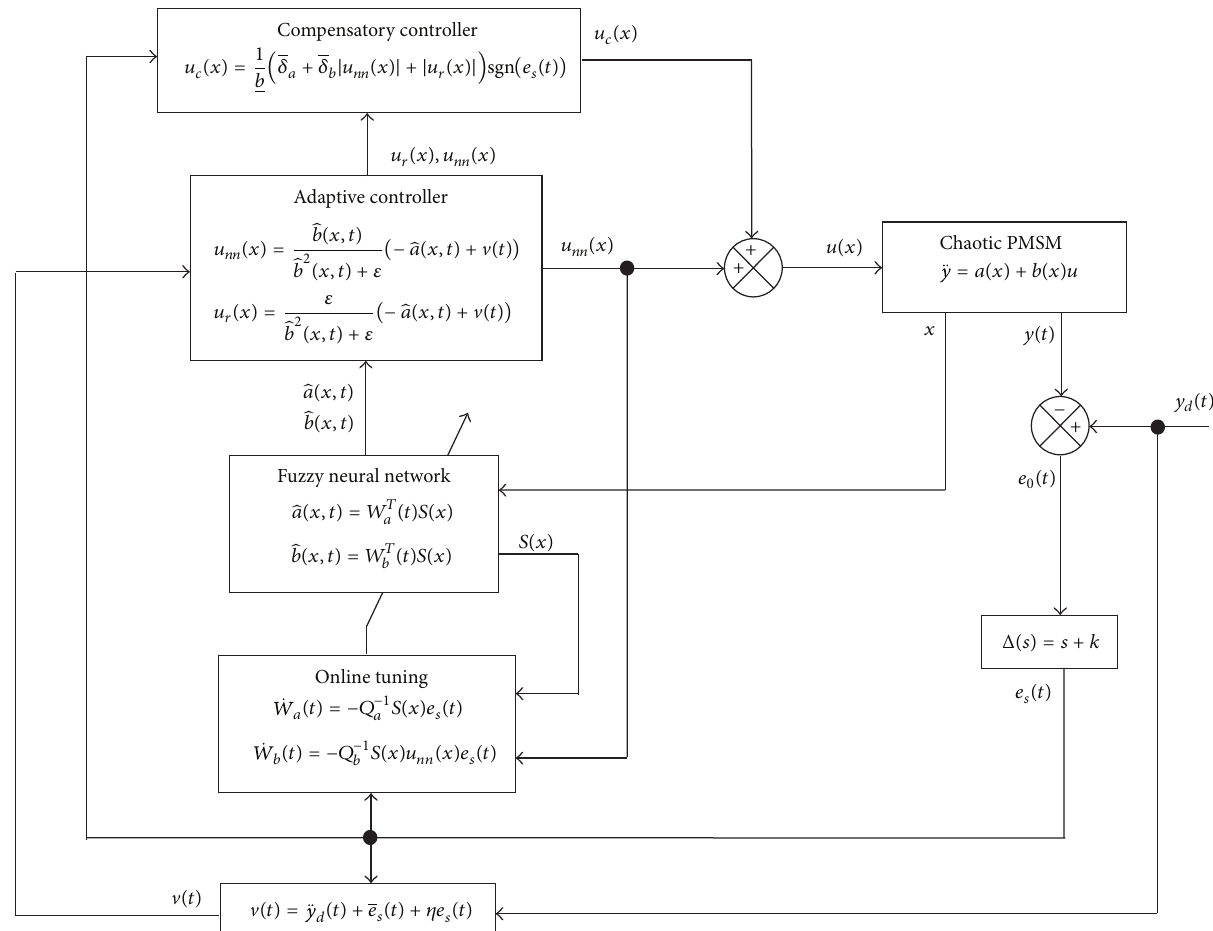
Figure 4: Overall scheme of the adaptive